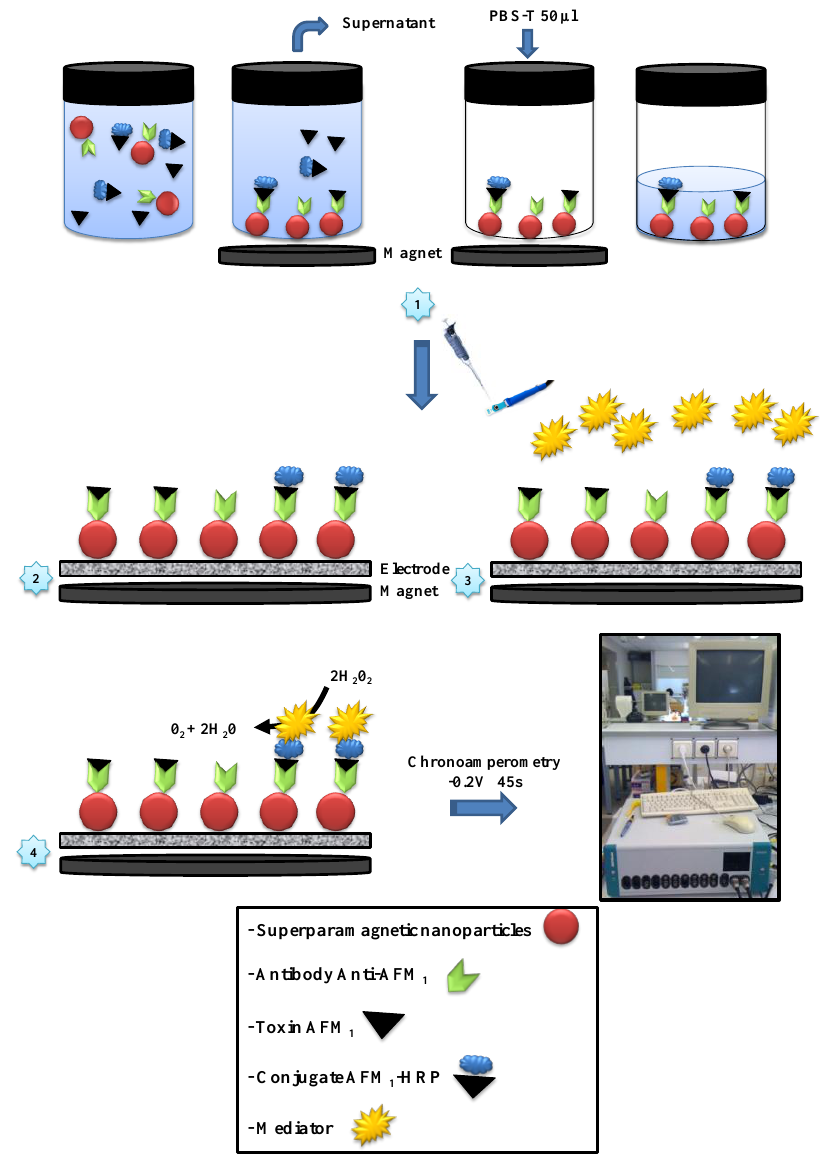
Figure 1. Immunosensor protocol and principle of the electrochemical immunosensor for AFM 1